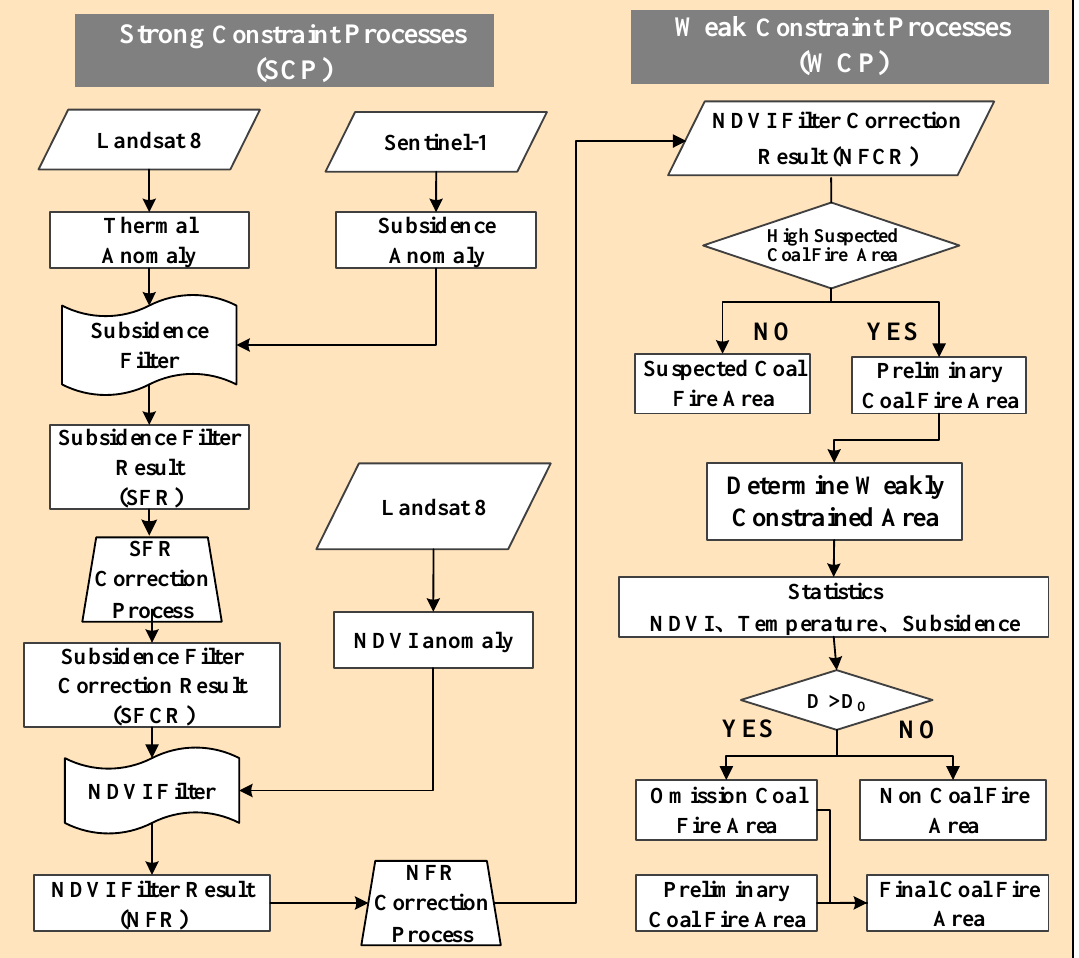
Figure 3. Flow chart of strength and weakness constraint method (SWCM). D represents the result value of normalized difference vegetation index (NDVI), temperature, and subsidence. D 0 represents the threshold values of a thermal anomaly, subsidence anomaly, and NDVI anomaly.